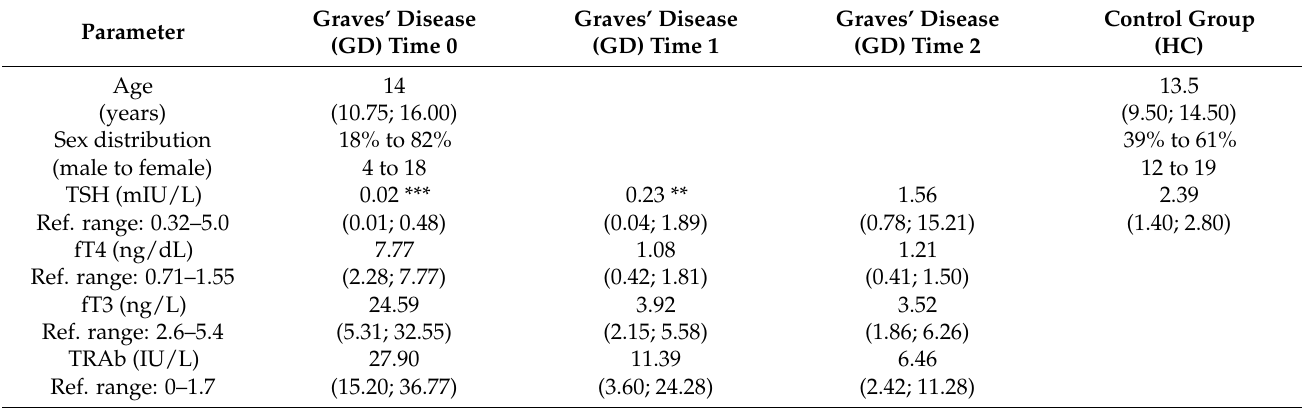
Table 1. Clinical description of the studied groups Graves’ disease patients (GD) and the healthy control group (HC). Graves’ disease patients were classified on the course of treatment: before treatment (Time 0), after 3 months (Time 1) and 1 year of treatment (Time 2). Data presented as median values with 25th and 75th percentile in the brackets. The significant differences were evaluated compared to the control group (** p < 0.01; *** p <